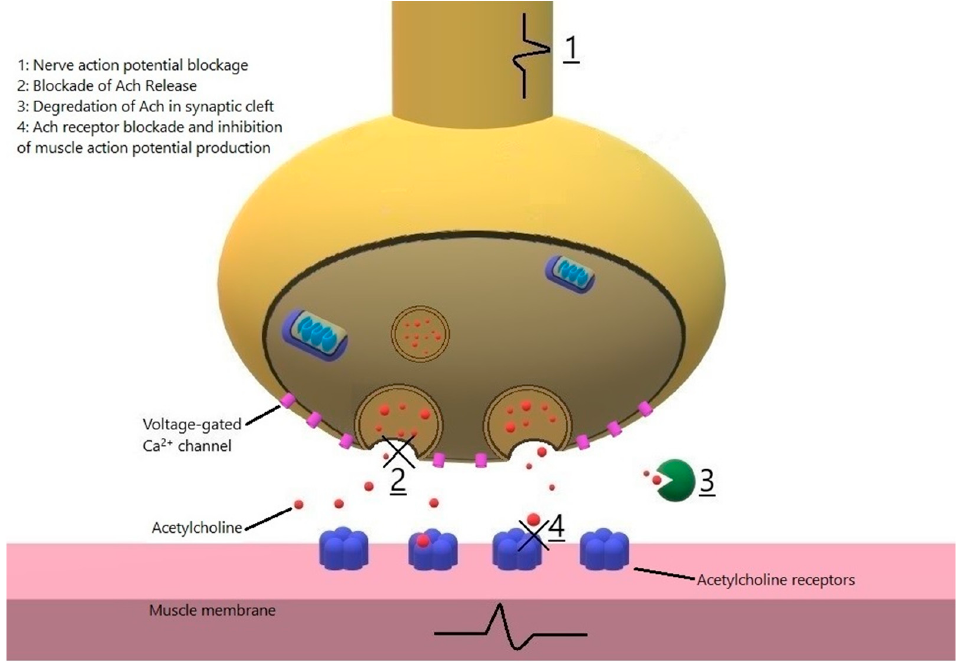
Figure 1. Proposed mechanisms of effects of drugs on neuromuscular junction.